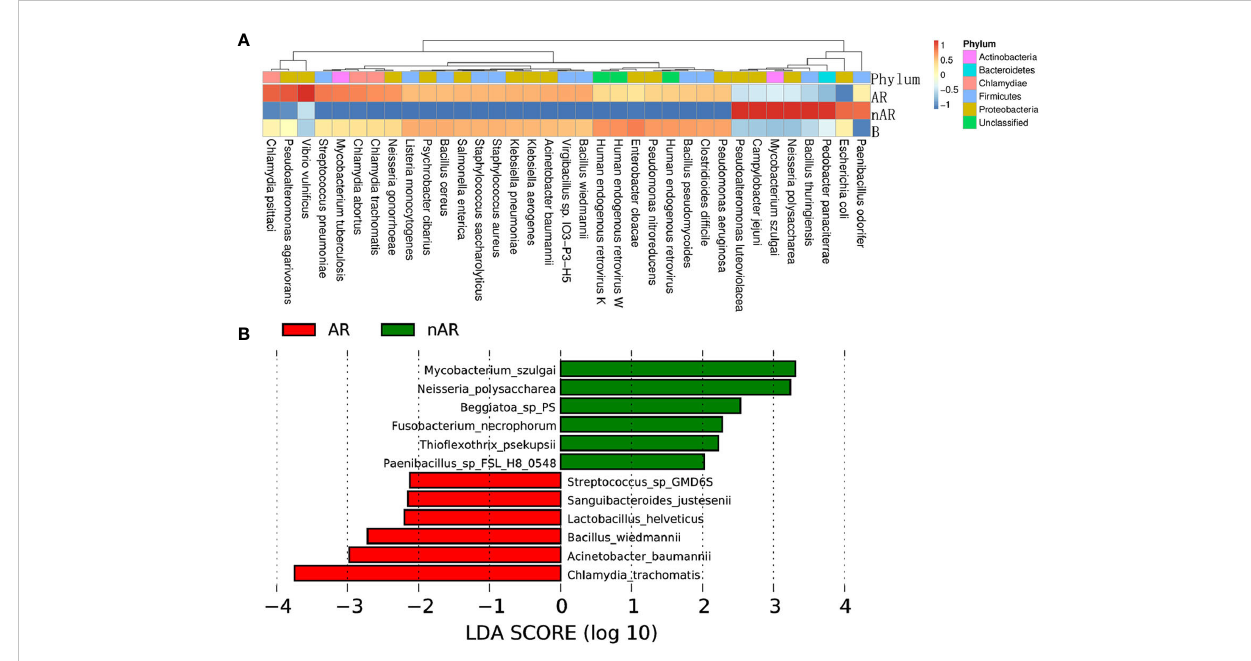
FIGURE 7 Differences in bacterial composition between AR and nAR in the heat map (A) and LEfSe analysis (B) by macrogenome